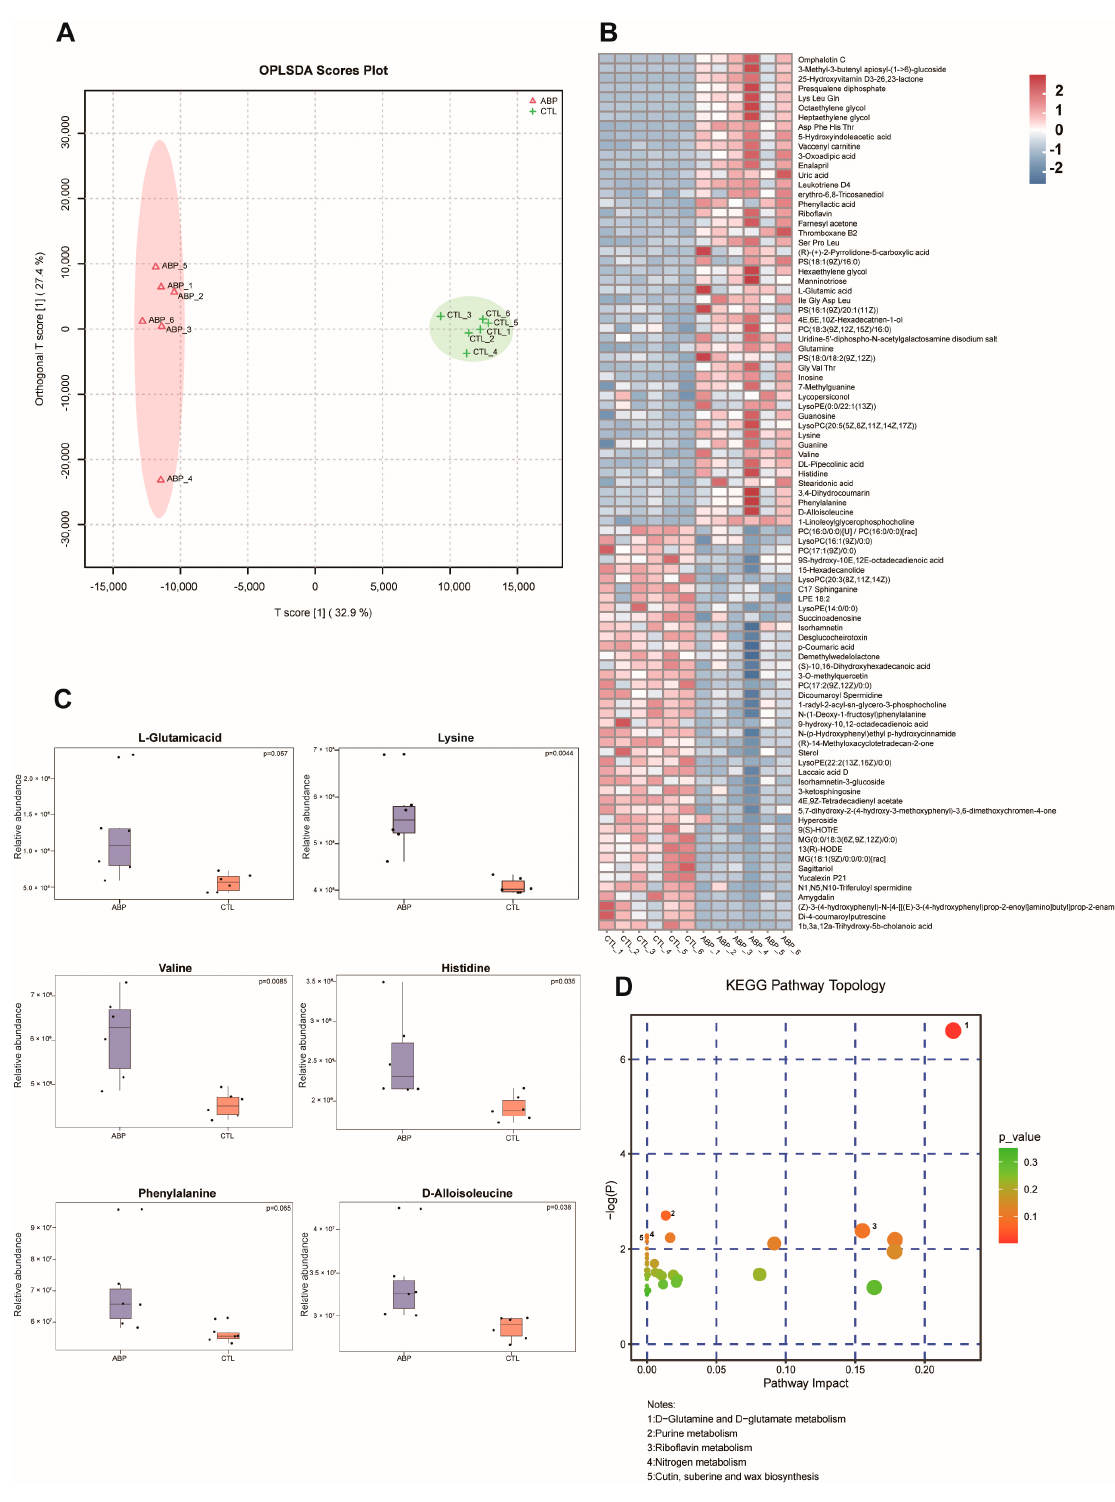
Figure 3. ( A ) Orthogonal partial least squares discriminant analysis (OPLS-DA) score plot between ABP-treated and control honeybees. ( B ) The heatmap visualization of the significant different metabolites between the ABP and CTL groups. Relative abundance is represented as color range from low level ( − 2, blue) to high level (2, red). ( C ) Fold change analysis describing alteration trend in computed means of related metabolites in ABP (purple bars) compared against the CTL (red bars). ( D ) Summary diagram of the pathway analysis with